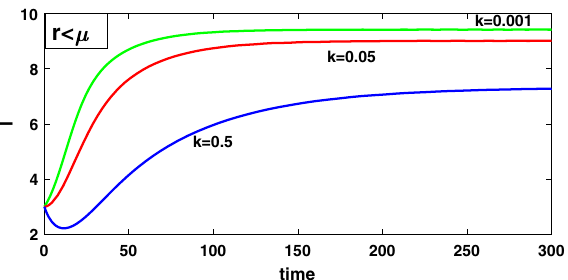
Fig. 10 A dynamical behaviour of the infected population with different values of k when r < µ